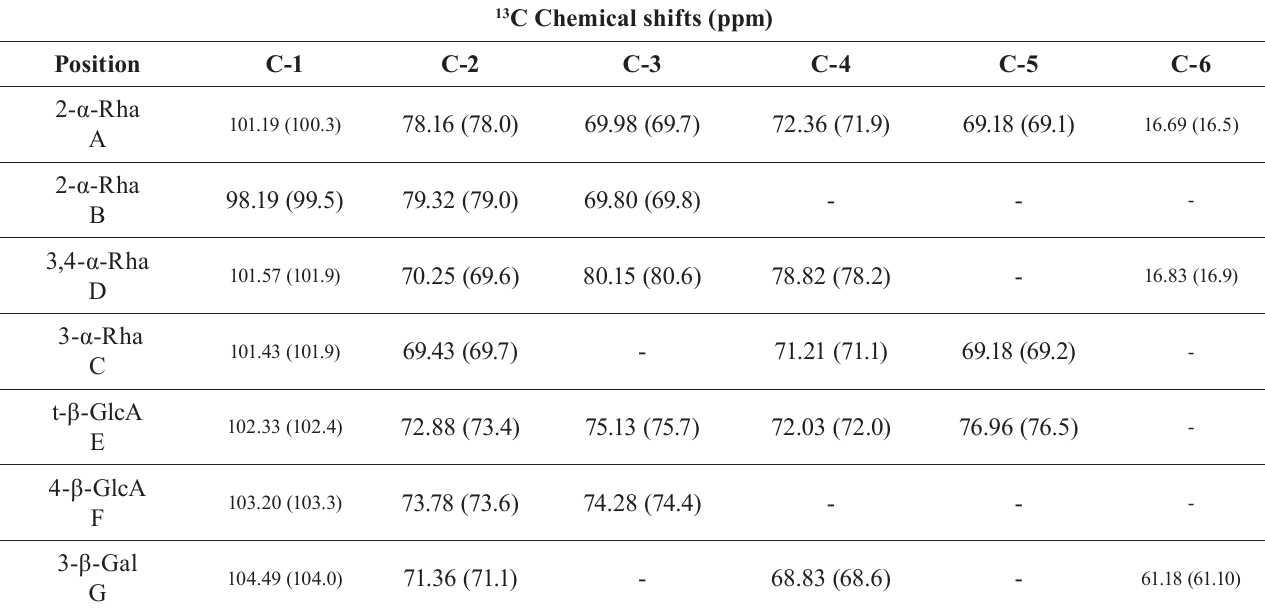
O) NMR chemical shifts of KEPS from K. 2